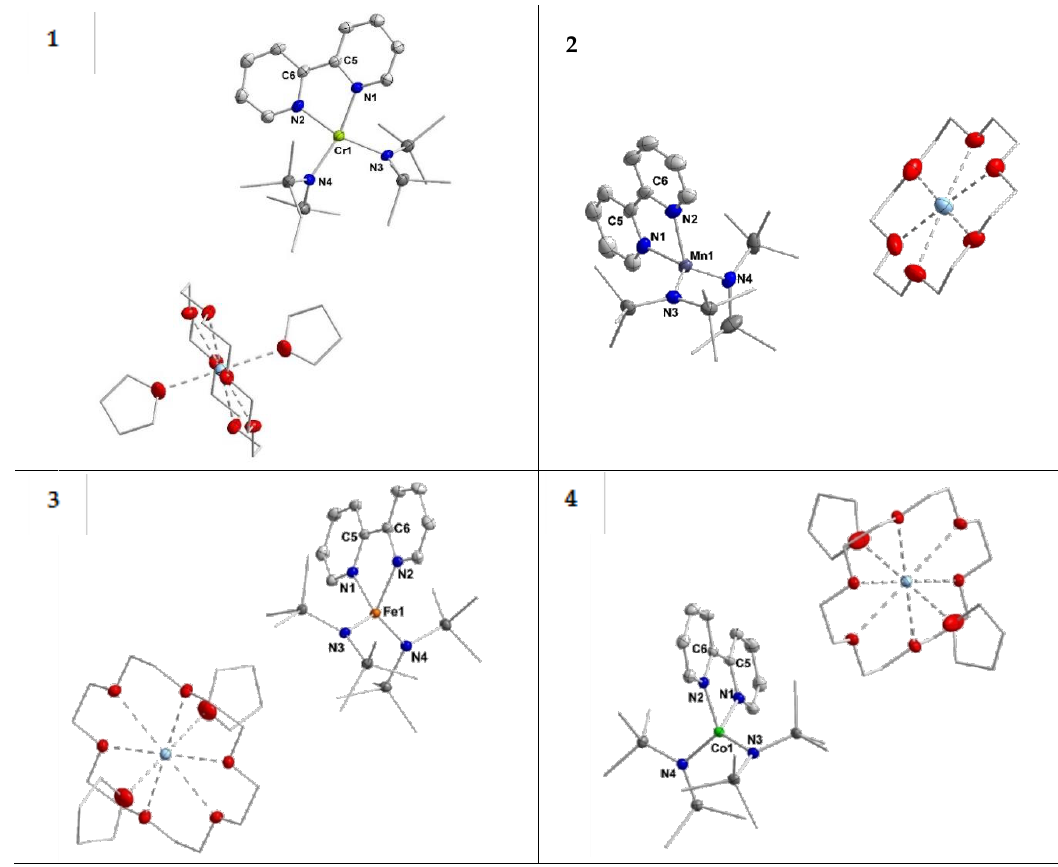
Figure 1. Molecular structures of compounds 1 – 4 . H atoms are omitted for clarity and ellipsoids are shown at 50% probability.